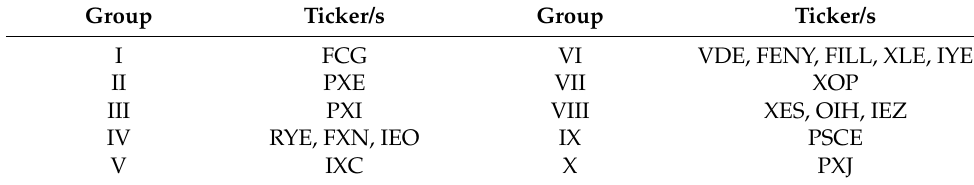
Table A2. Clustering result.